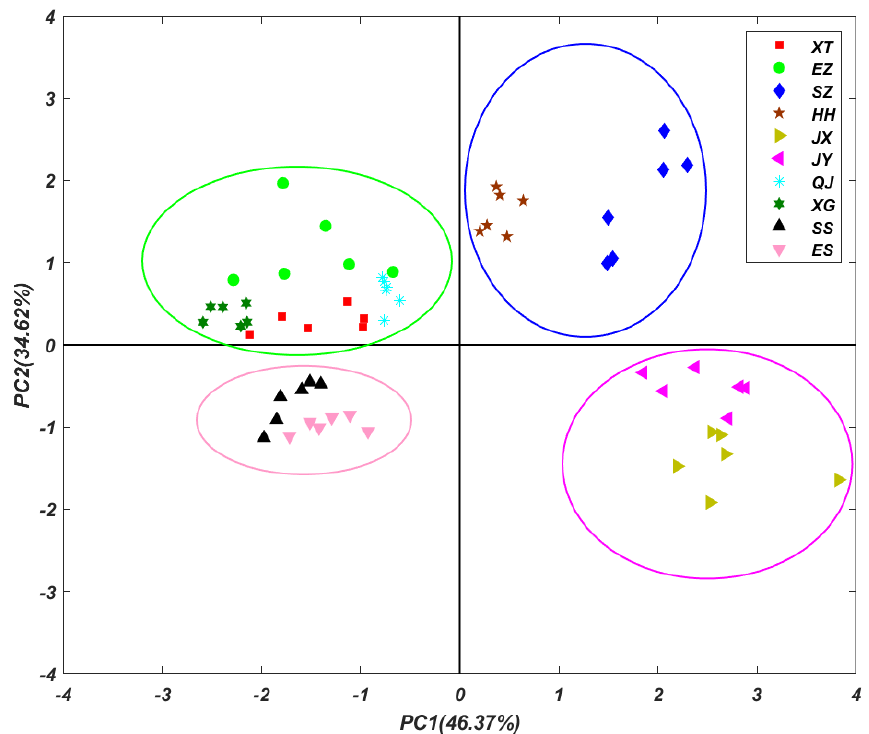
Figure 4. The scores of PC1 and PC2 in principal component analysis of crayfish (whole crayfish) in different areas along the Yangtze River Basin of Hubei Province.